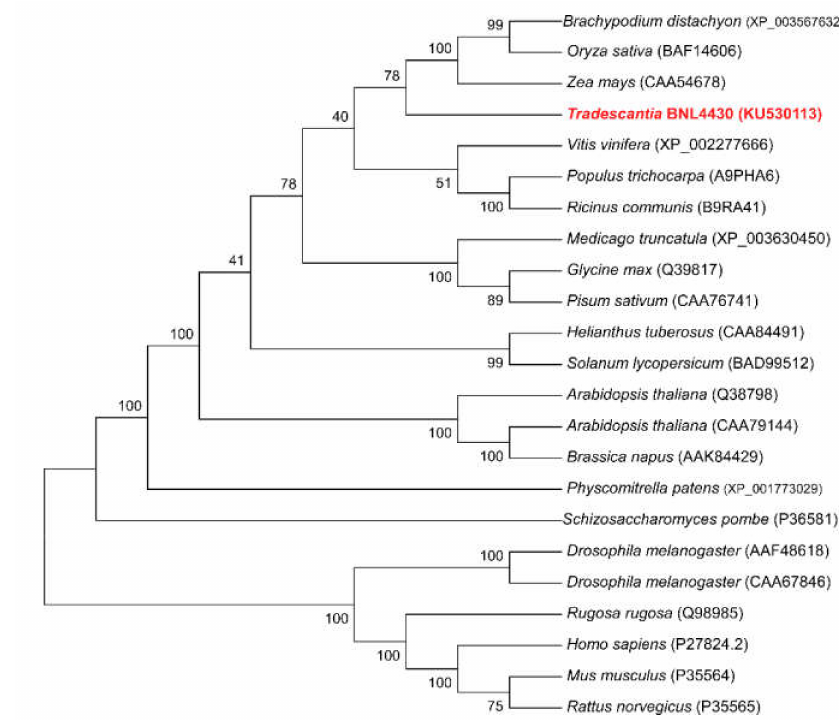
Figure 3. Phylogenetic tree of CNX based on the amino acid sequences from Tradescantia along with plant and non-plant species. A neighbor-joining tree was built using MEGA 4.02. A Dayho ff matrix-based method was used to estimate the branch support. The bootstrap values in branches were obtained by 1000 replications. Species name and accession numbers of CNX proteins represent the sources of CNX proteins in the